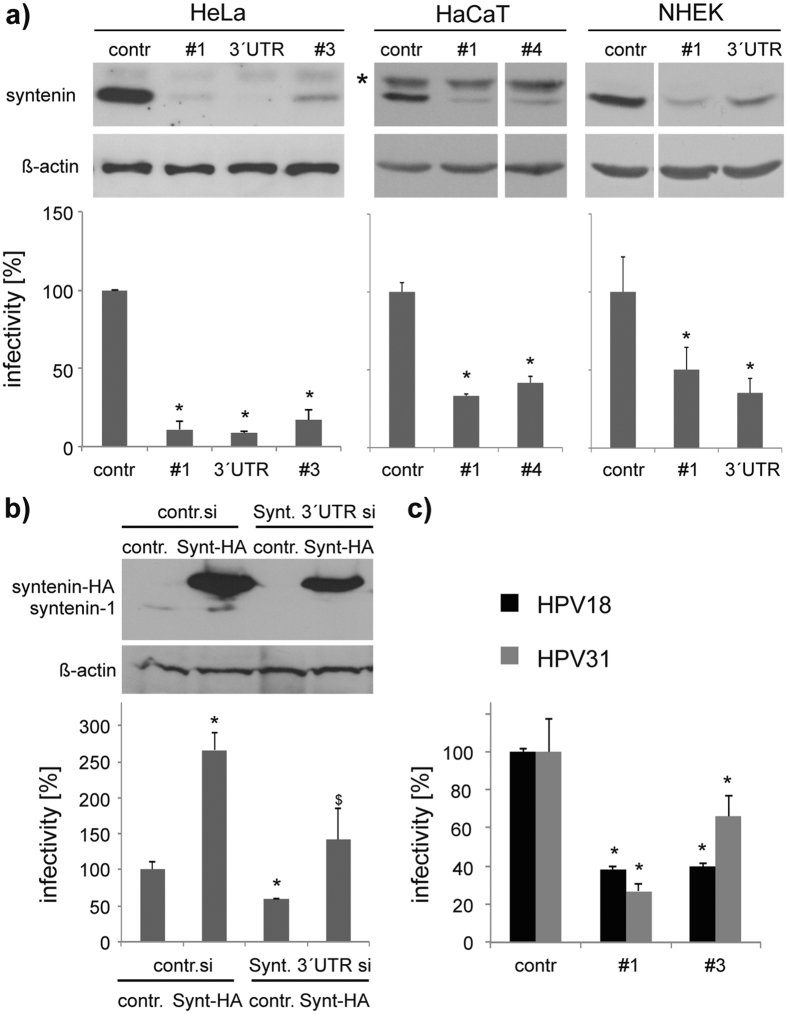
Syntenin-1 is required for papillomavirus infection.(a) Syntenin-1 knockdown correlates with reduced HPV16 infectivity. Upper panels show efficiency of syntenin-1 knockdown in HeLa, HaCaT, and NHEK cells (*non-specific band). Bottom panels show correlating HPV16 infection assay in HeLa, HaCaT and NHEK cells after syntenin-1 or control siRNA treatment. Infectivity was measured as in Fig. 1b. (b) HPV16 infectivity can be restored after syntenin-1 reexpression. HeLa cells were treated with syntenin-1 siRNAs, transfected with control or syntenin-1-expression plasmid and then infected with HPV16 PsV. Infectivity of HPV16 PsV was analysed as above. Upper panels show the efficiency of syntenin-1 knockdown and reexpression. *P < 0.05 significant decrease compared to control, $P < 0.05 significant increase compared to cells transfected with syntenin 3′UTR siRNA and control plasmid. (c) Syntenin-1 knockdown correlates with reduced HPV18 and HPV31 infectivity. HeLa cells were treated as in (a) and infectivity of HPV18 or HPV31 PsV was analysed as above.